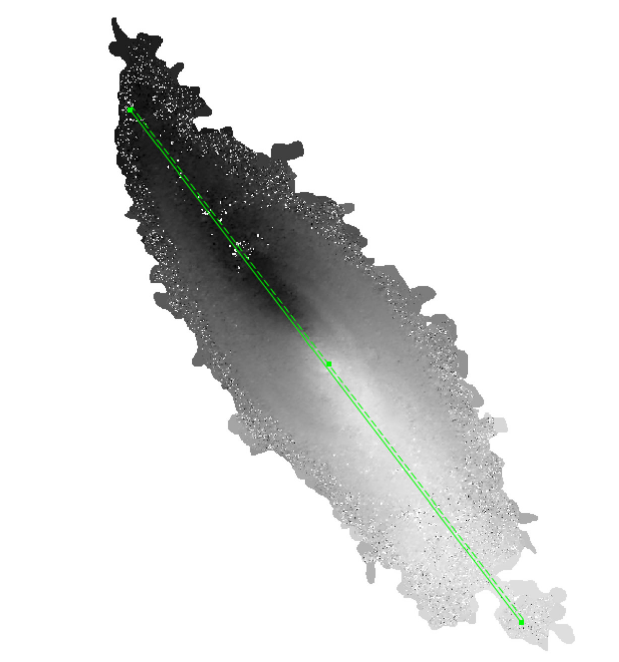
Fig. 48.— A profile shape laid along the major axis of the galaxy NGC 3198’s THINGS first moment map. Now, click on one point of the image, hold your mouse button and drag to another point. DS9 will join the two points with a slim rectangle and, at the same time, open a new window that shows the profile of pixel values along that slim rectangle. Pixel values are averaged over the direction perpendicular to the profile; in that way, you can iron out some of the local variations (including noise) and get an accurate representation of trends on larger scales. 14 If the profile window has gotten lost, select the region and double-click the region window; in the top menu, under “Analysis”, uncheck and re-check the “Plot 2D”, and the profile window should re-appear. Click on that rectangle while still in region mode, and little dots appear — you can drag the outer dots around to change the position, orientation and length of the pro- jection area, and the centre dot to change the width.